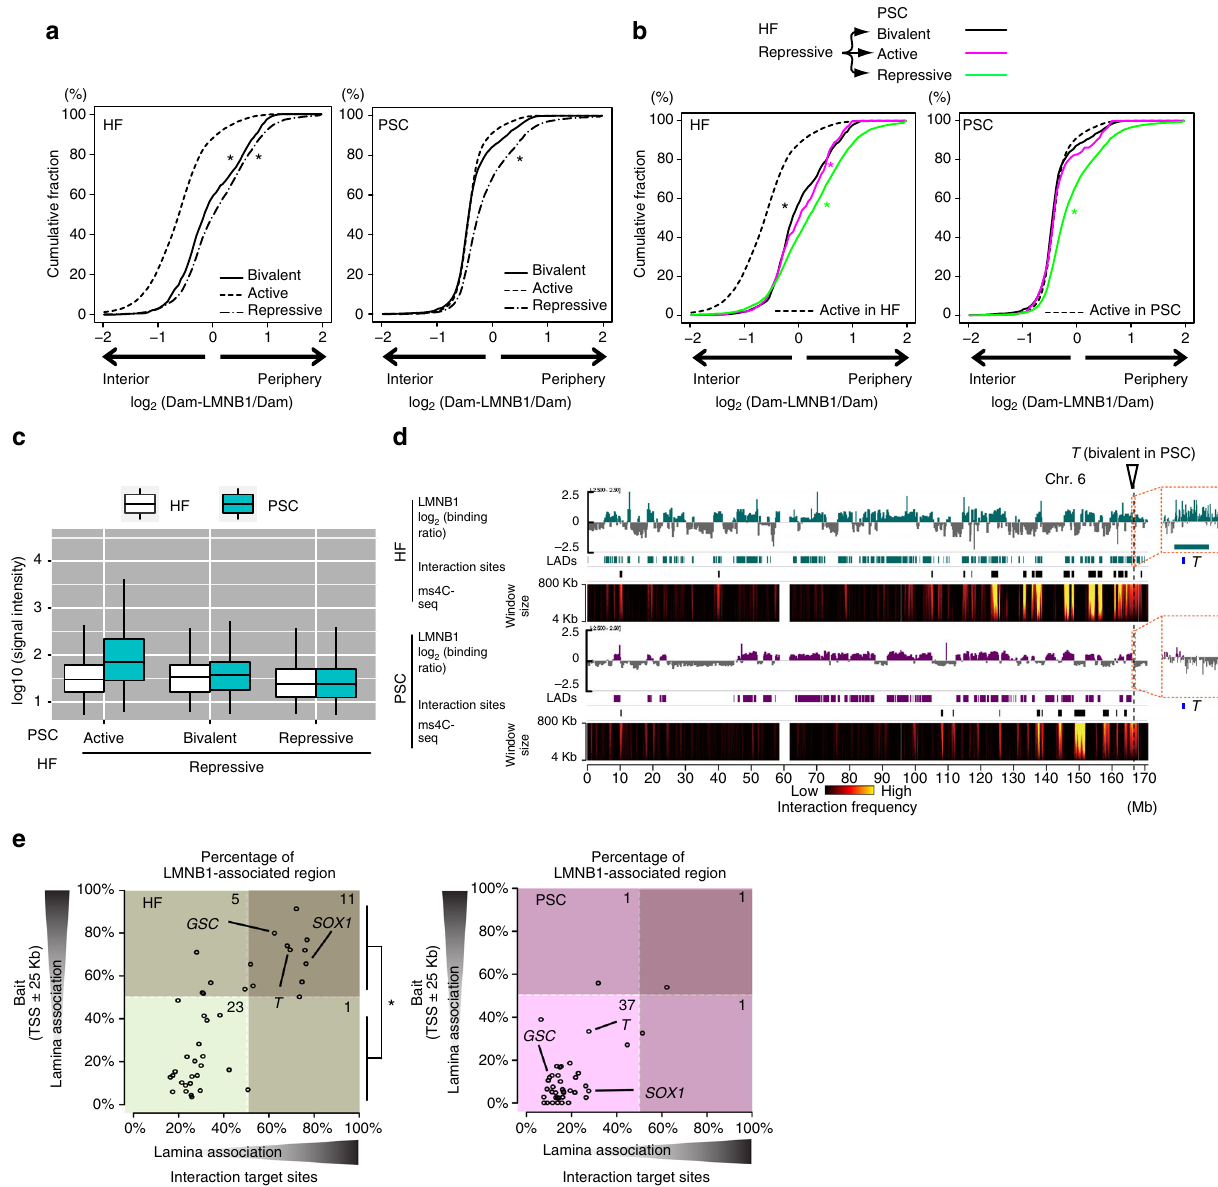
Fig. 4 Nuclear positions at bivalent gene loci in somatic cells and hPSCs. a Cumulative distribution of the lamina-association signals (log 2 (Dam-LMNB1/ Dam) values 39, 40 ) at active (dashed line), repressive (dash-dot line), and bivalent (solid line) gene loci in HFs and PSCs (ESCs). * p < 3.0 × 10 − 16 for Mann – Whitney U -test using active genes for the comparisons. b Cumulative distribution of the lamina-association signals (log 2 (Dam-LMNB1/Dam) values 40, 41 ) for the genes which change their states from repressive in HFs to active (magenta), repressive (green), or bivalent (black) in PSCs (ESCs). * p < 3.0 × 10 − 16 for Mann – Whitney U -test using active genes for the comparisons. c Comparison of expression values for the indicated gene groups in iPSCs and their original HFs (HDFs). The boxplots indicate the distribution of log 10 (signal intensity) values. The box plots are colored by cell types. d The relationship between chromatin interaction pro fi les and lamina-association pro fi les at T gene bait loci in HFs and hPSCs. The positive log 2 (Dam-LMNB1/ Dam) signals 40, 41 are indicated by the green (HFs) or magenta (PSCs (ESCs)) bar chart above the HF and PSC tracks. Positive log 2 (Dam-LMNB1/Dam) signals indicate lamina-associated regions. Rectangles below each signal track depict lamina-associated domains. The interaction frequencies determined by ms4C-seq in HFs (HDFs) and iPSCs are shown as described in Fig. 2a. e The subnuclear localization of the bait loci and their interaction target loci in HFs (top) and PSCs (iPSCs, bottom). Scatter plots present the strength of the lamina association of the bait gene loci (TSS ± 25 kb) ( y -axis) and their interaction target loci located in the nuclear periphery in HFs and the nuclear interior in PSCs